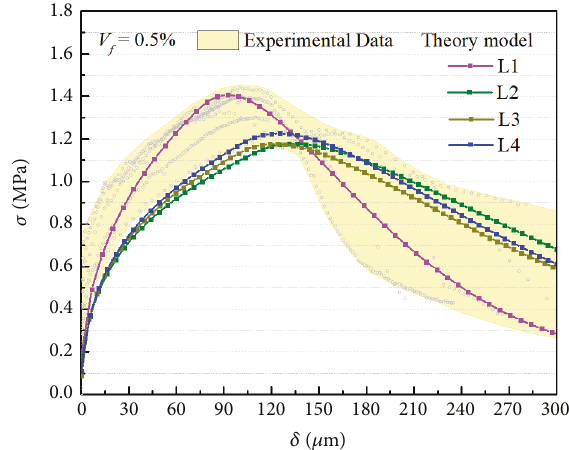
Figure 19: Comparison of predicted and experimental σ − δ